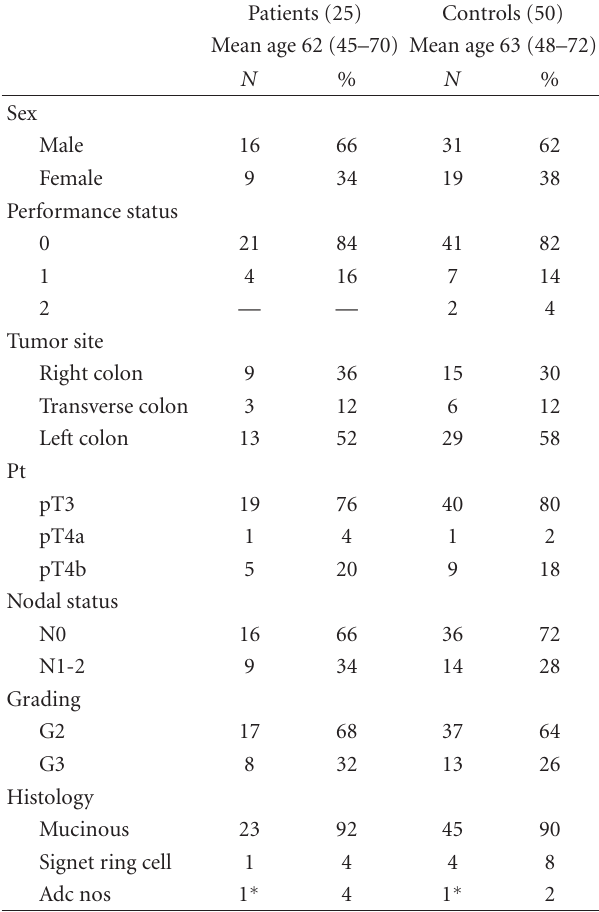
Table 1: Clinical characteristics of the 2